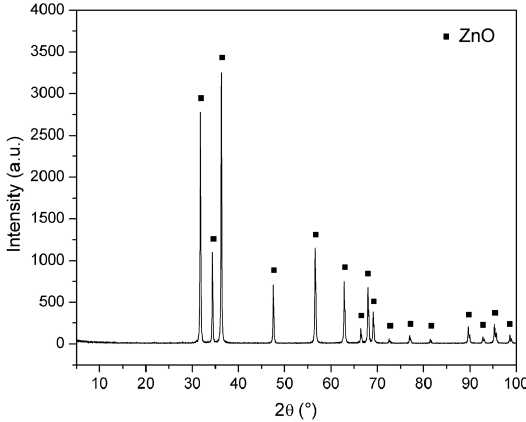
Figure 2. X-ray diffractogram of the leached zinc oxide recovered by the spent alkaline battery